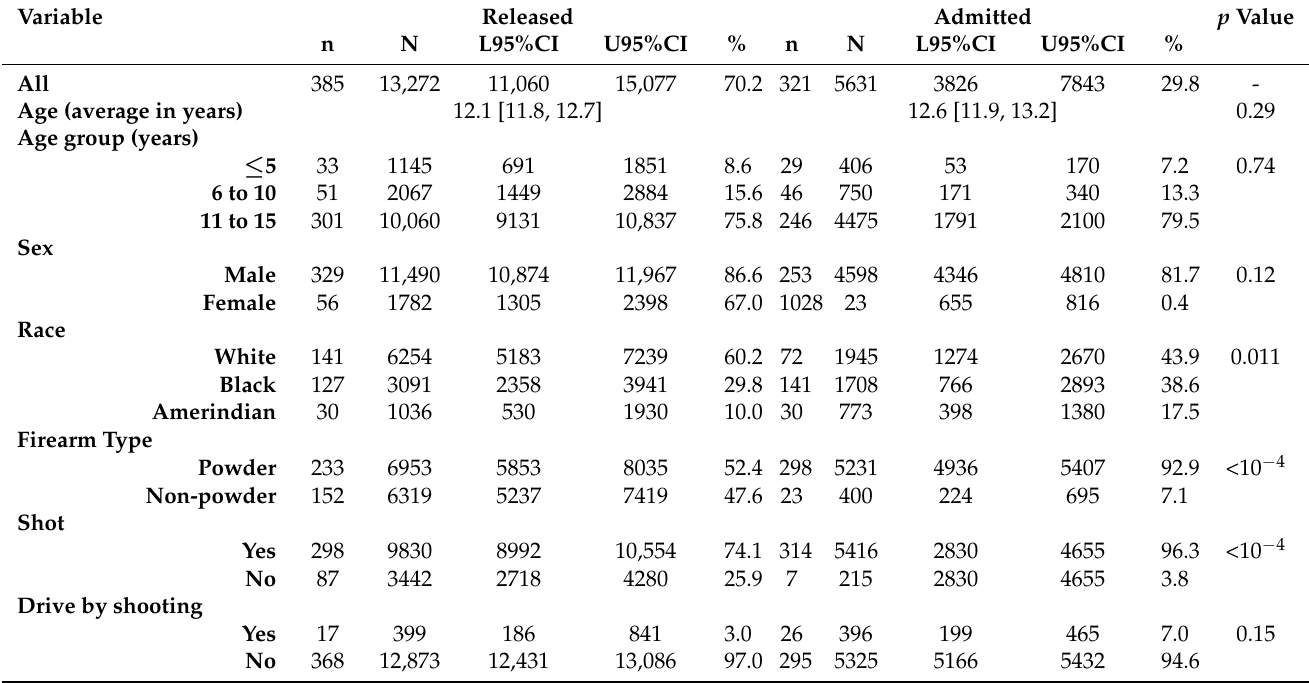
Table 6. Analyses by disposition from the ED.